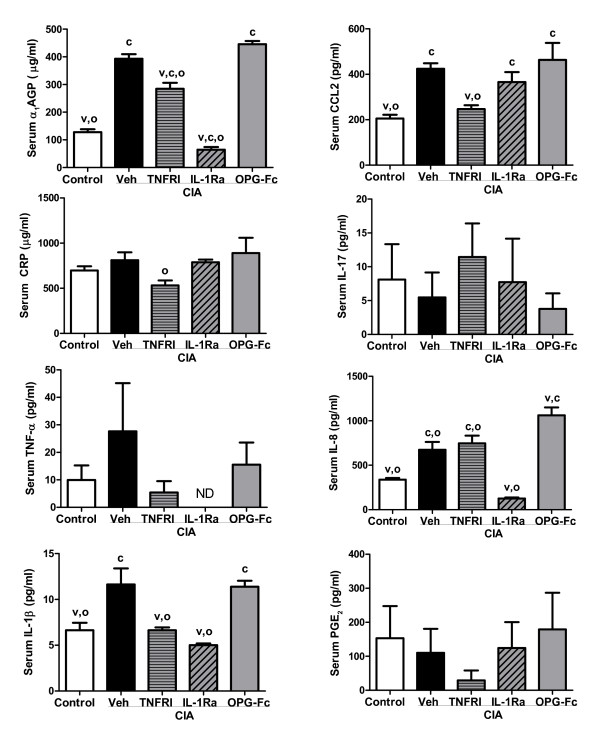
Serum markers and mediators of inflammation in collagen-induced arthritis (CIA) rats. Values were determined on day 14 post onset, 10 days after the initiation of treatment. Data represent means ± standard error of the means, n = 8/group. cSignificantly different from control (non-arthritic) rats, P < 0.05. vSignificantly different from vehicle (Veh)-treated arthritic rats, P < 0.05. oSignificantly different from osteoprotegerin (OPG)-treated arthritic rats, P < 0.05. α1AGP, acute-phase protein alpha-1-acid glycoprotein; CCL2, chemokine (C-C motif) ligand 2; CIA, collagen-induced arthritis; CRP, C-reactive protein; PGE2, prostaglandin E2.